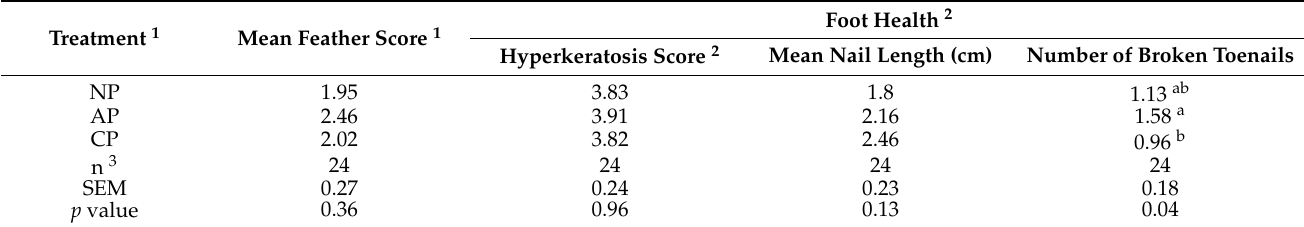
Table 2. The effects of cooled perches on hen feather score and foot health at 80 weeks of age. Treatment